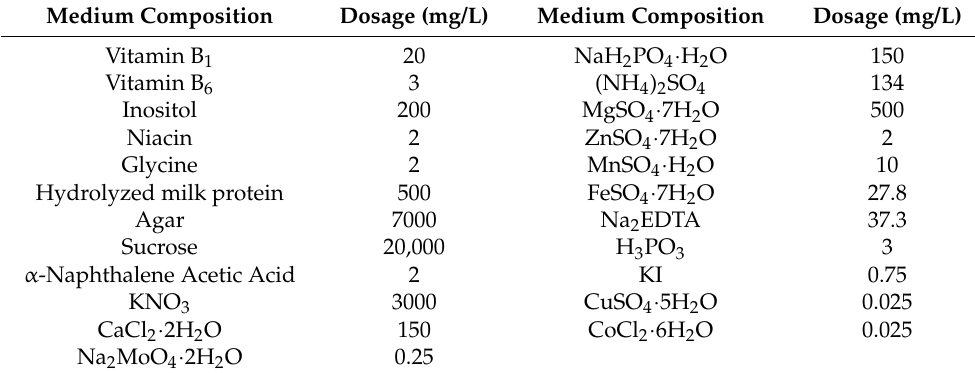
Table 1. B 5 solid medium